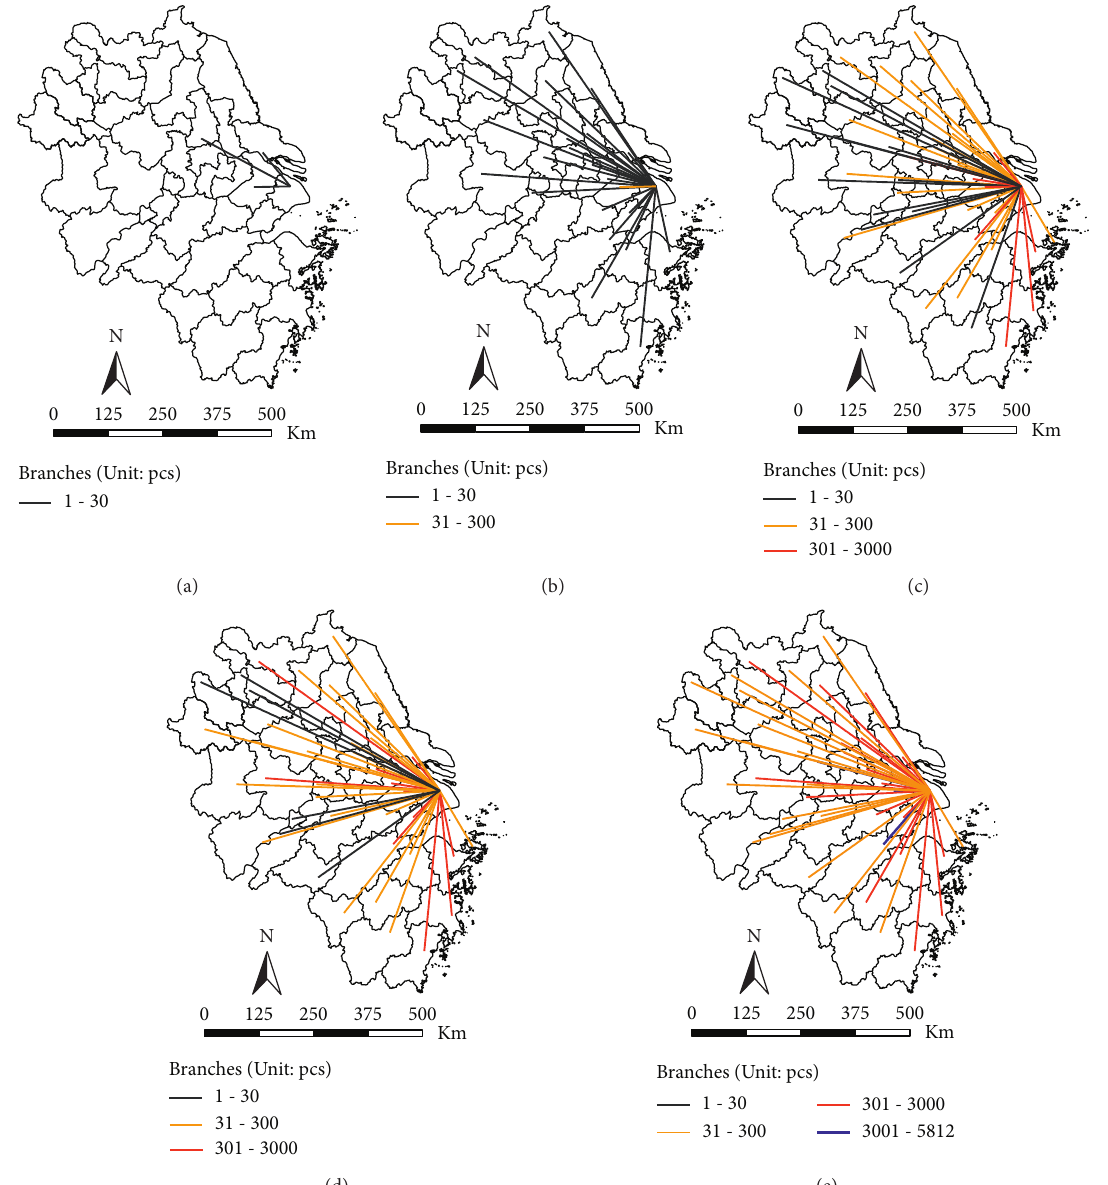
Figure 3: Headquarters-branch enterprise linkages between Shanghai and hinterland cities. (a) 1978. (b) 1992. (c) 2003. (d) 2009. (e)